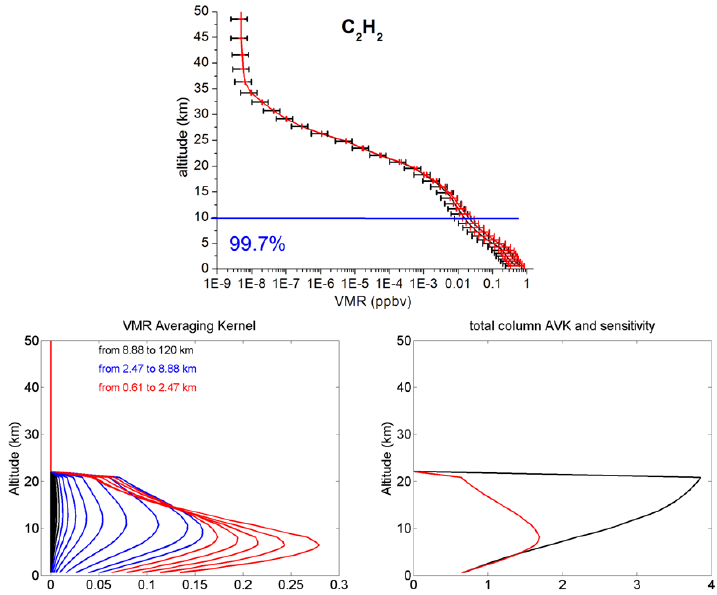
Figure 6. Same as Fig. 3 but for C 2 H 2 . The C 2 H 2 a priori VMR profile is from MkIV balloon measurements made at the high-latitude NDACC site of Kiruna, at between 6 and 34km altitude, combined with spitprim.set (Ft. Sumner MkIV flights, 1990s, http://mark4sun.jpl.